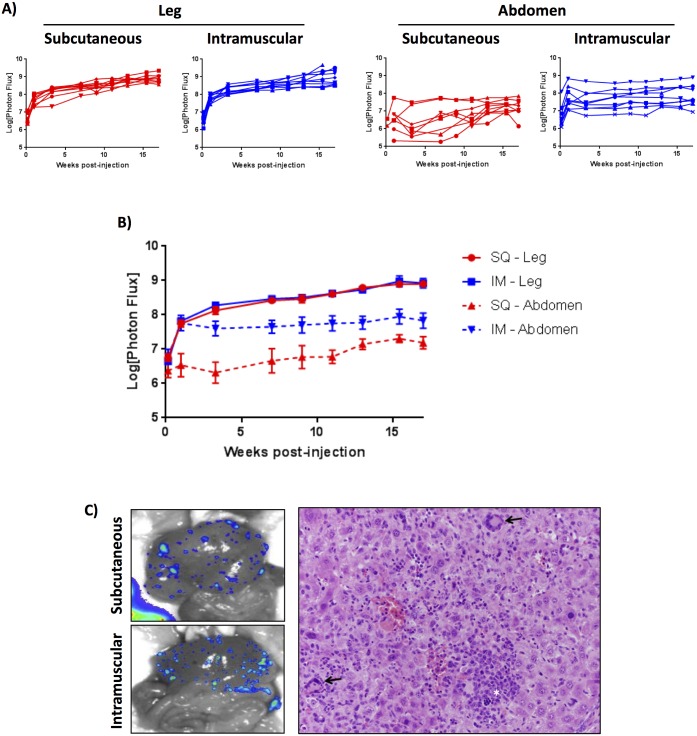
IM-injected Ad CMV-Cre results in increased systemic viral spread.A) Quantified leg-only or abdomen-only BLI values are shown for individual Trp53fl/flPtenfl/fl mice injected either SQ or IM with Ad CMV-Cre. B) Comparisons between injection cohorts demonstrate lower non-specific signal in the abdomen with SQ injection. There was no significant difference in luciferase signal between the SQ- or IM-injected legs; however, there is a significant difference between SQ and IM abdomen injections for week 1 and beyond (p<0.05). The difference in comparison to the first day post-injection was statistically significant for both SQ (p<0.002) and IM (p<0.0001) leg injections as well as IM abdominal BLI (p<0.02). No significant difference was found for SQ abdominal BLI in comparison to day 1. C) Ex vivo BLI images of livers from one SQ- and one IM-injected mouse, depicting multifocal low-level recombination and luciferase expression in the livers of mice with abdominal BLI signal, suggesting systemic viral spread and infection (left panels). Histological sections of liver demonstrated extramedullary hematopoiesis, noted with arrows, but no neoplasm was identified (right panel).